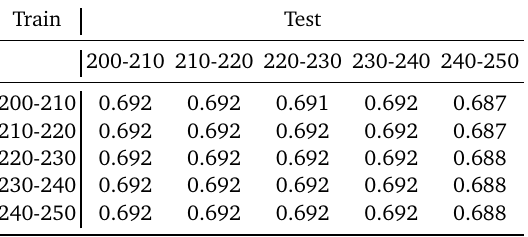
Table 2: Areas under the ROC curve for the L O L A tagger trained and tested on mono- jet samples sliced in p . The uncertainty on each entry is one to two units on the T , j last shown